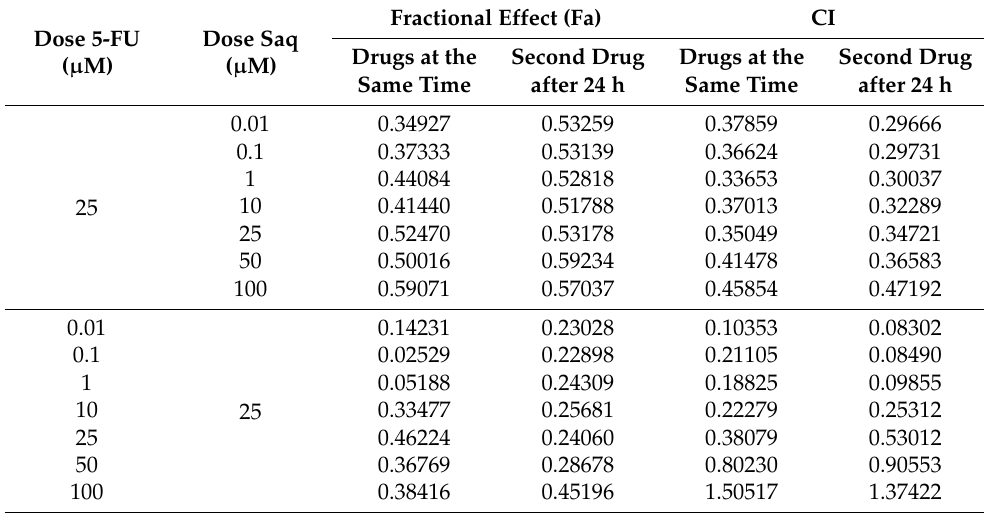
Table 5. Effect and CI values of 5-FU and SAQ combinations simultaneously or with the second drug being added after 24 h in A549 cells. CI < 1 represents synergism, CI = 1 represents additivity, and CI > 1 represents antagonism. The fractional effect shows the degree of cell death, ranging from 0 to 1, with 0 being no cellular death and 1 being total cellular